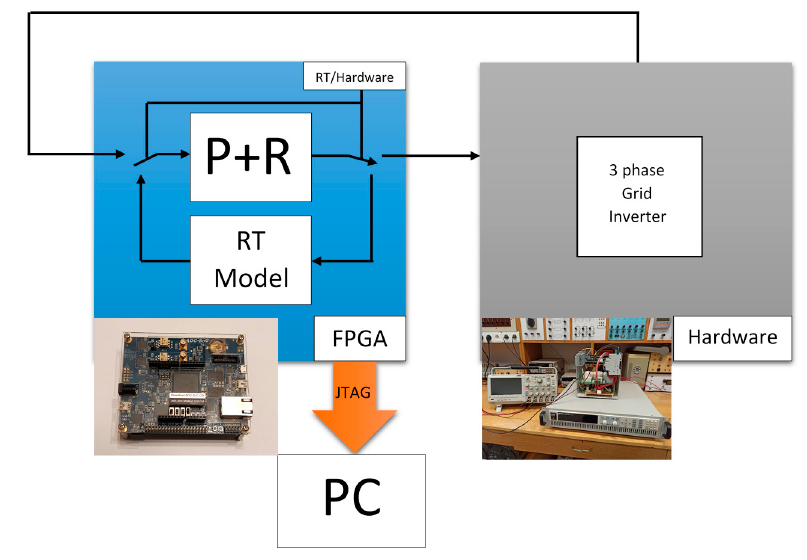
Figure 6. Laboratory stand with RT modeling in FPGA.